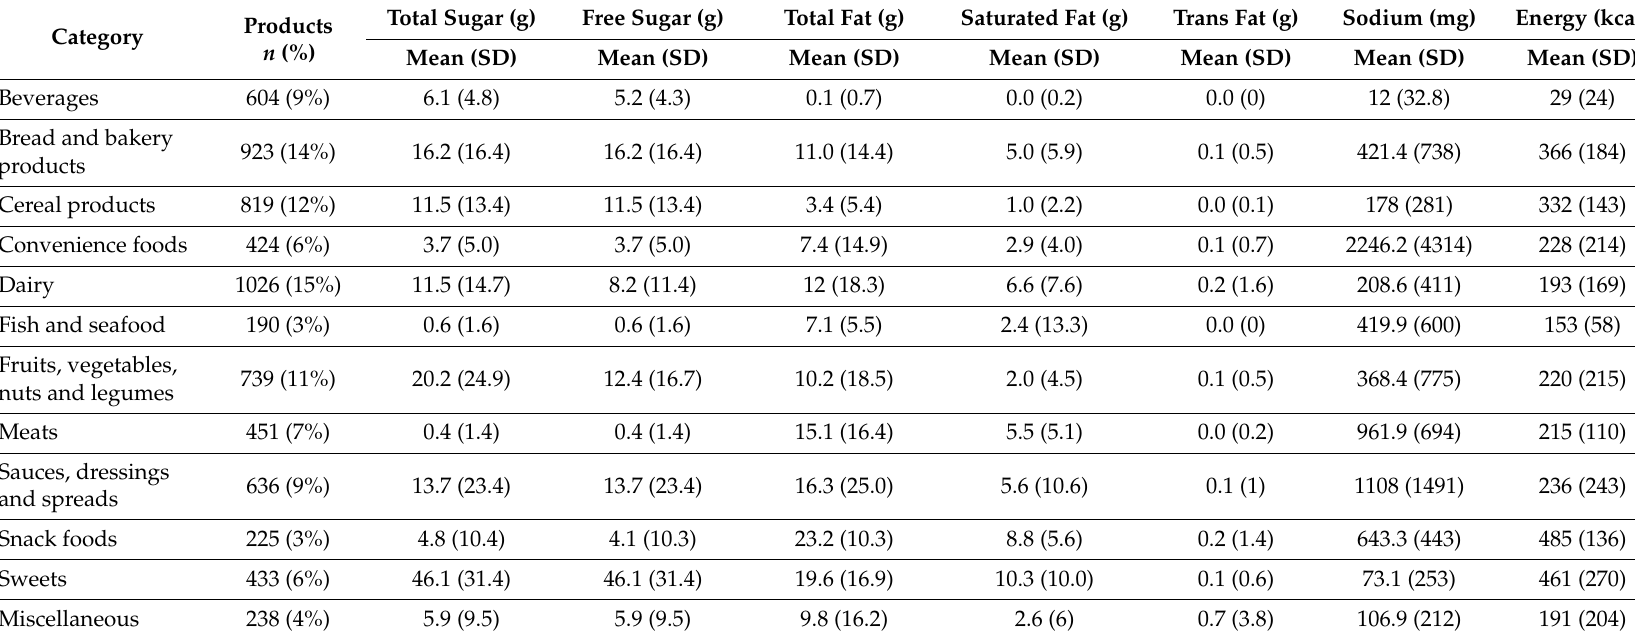
Table 1. Mean (standard deviation) of nutrient densities (per 100 g or per 100 mL) by food category for packaged food and beverage products available for purchase in Bogot á , Colombia ( n =